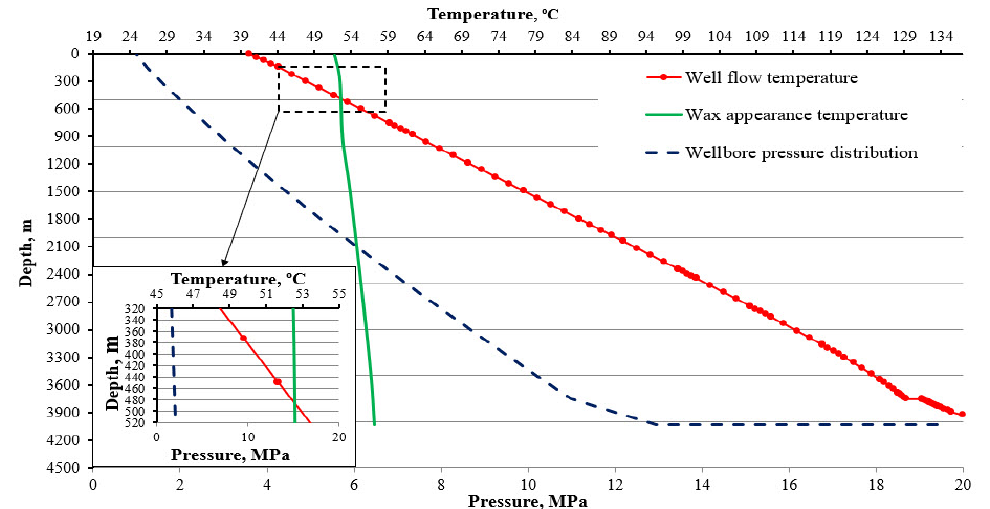
Figure 3. Determination of the depth of wax formation.